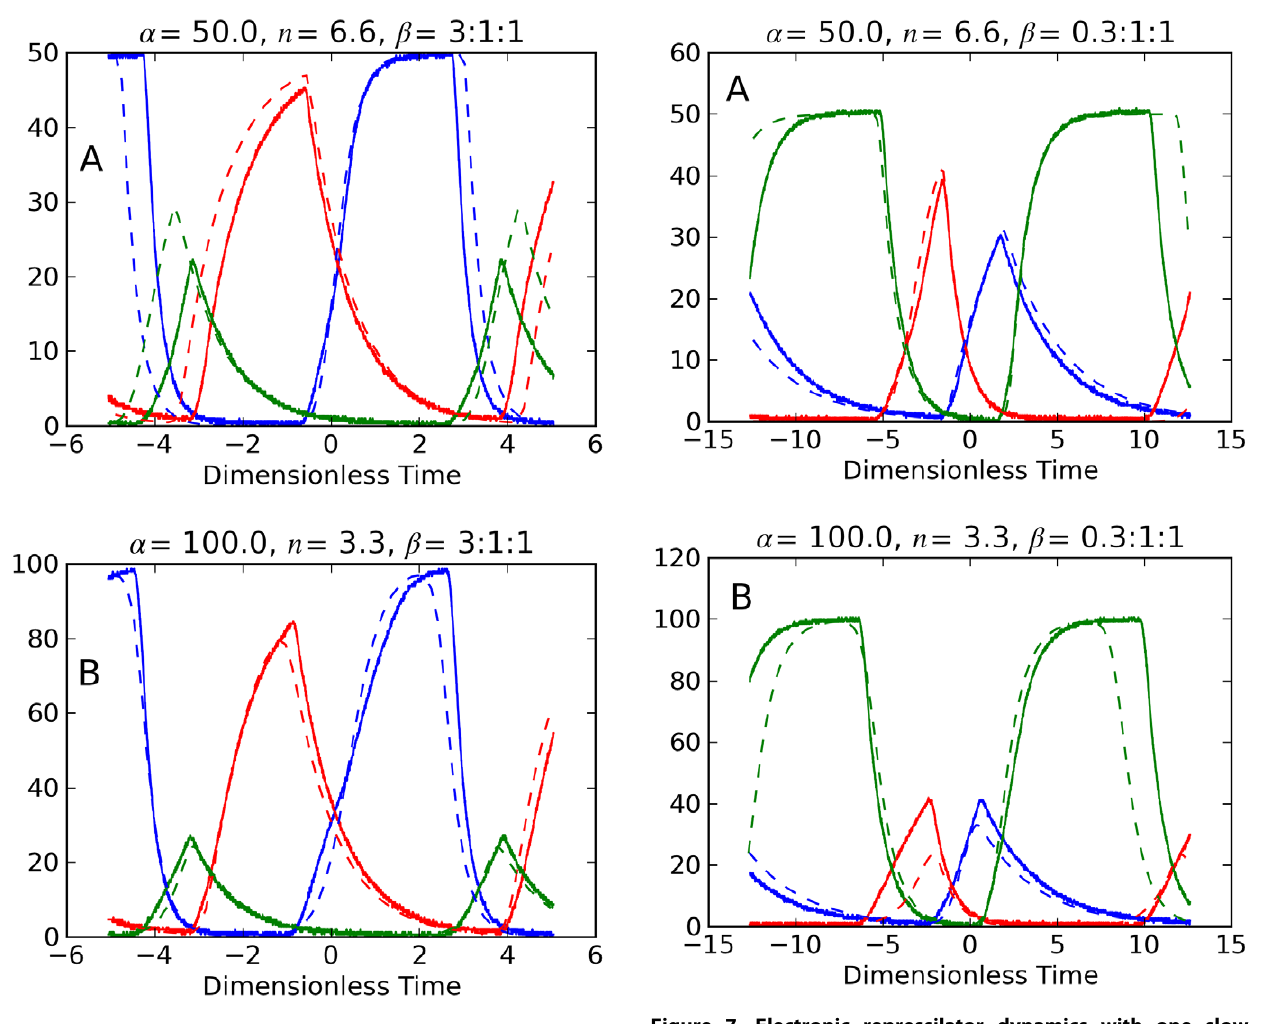
Figure 6. Electronic repressilator dynamics with one fast decay rate. Normalized voltages x i measured from RGN repressilator circuit (solid) and numerical predictions (dashed). b -ratio =3:1:1. Panel A ( a =50, n =6.6); Panel B ( a =100, n =3.3).